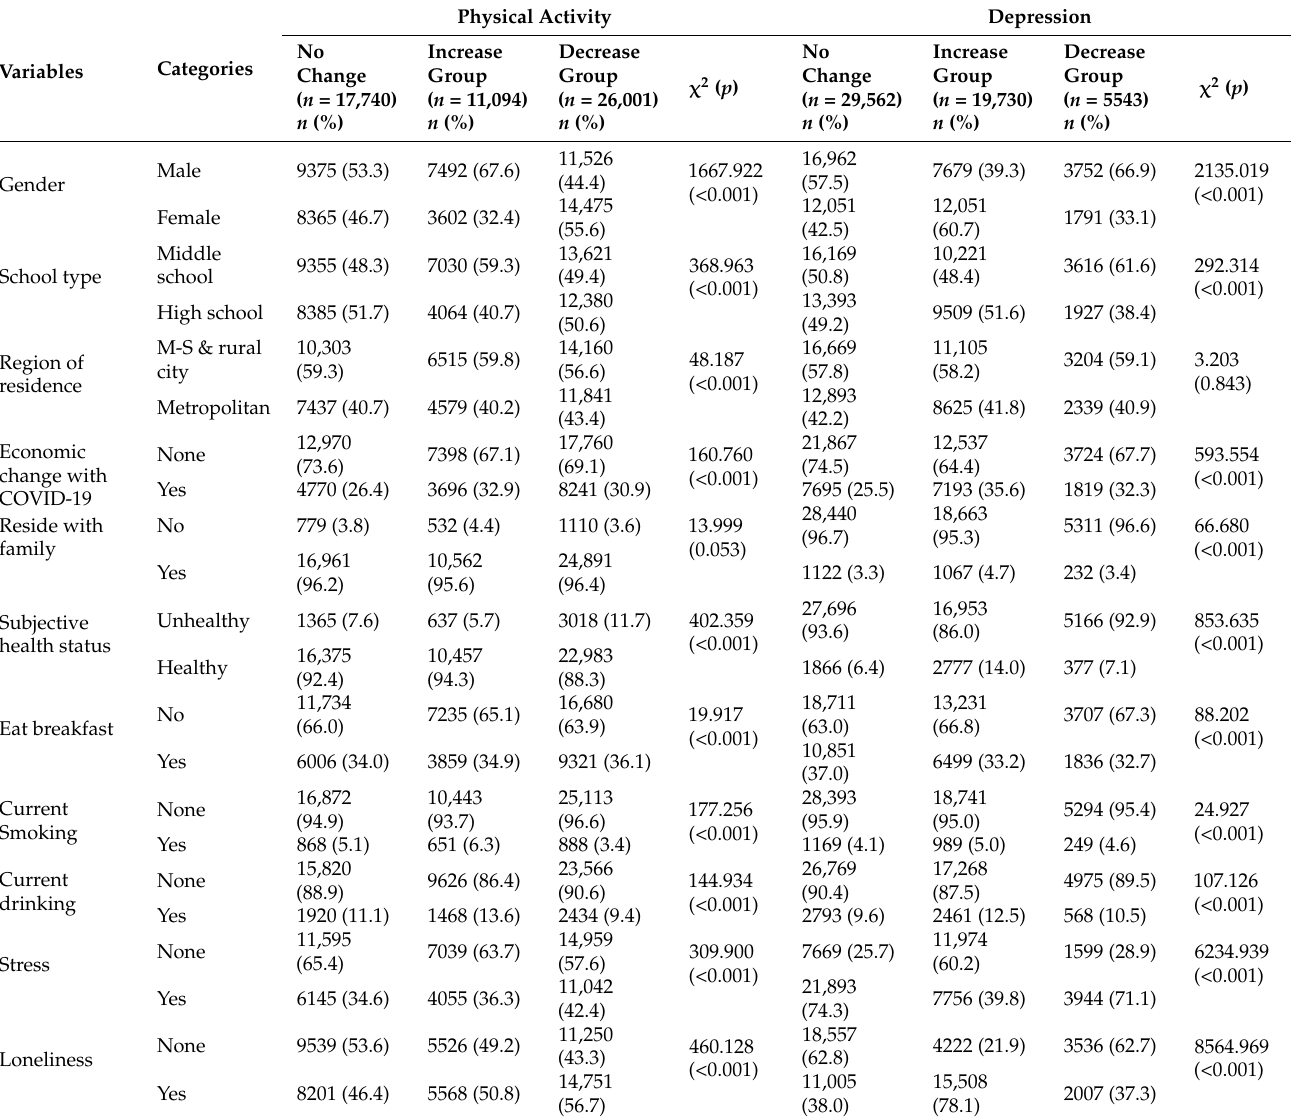
Table 3. Participants’ characteristics, health-related behaviors, mental health, and relationship to COVID-19 physical activity change and depression change ( n =